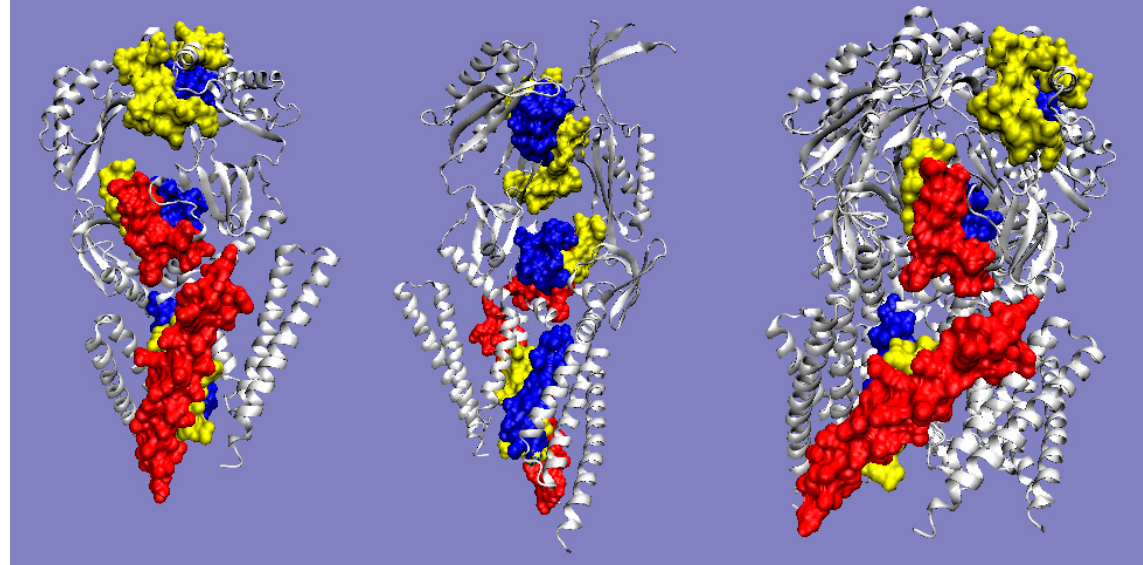
Figure 7. 3D presentation of the complex. Chain A distinguished in colors: red—hydrophobicity excess, blue—hydrophobicity deficiency, yellow—status accordant with the model. Left—surface view, central—channel view, right—complex. The white chains—other chains.